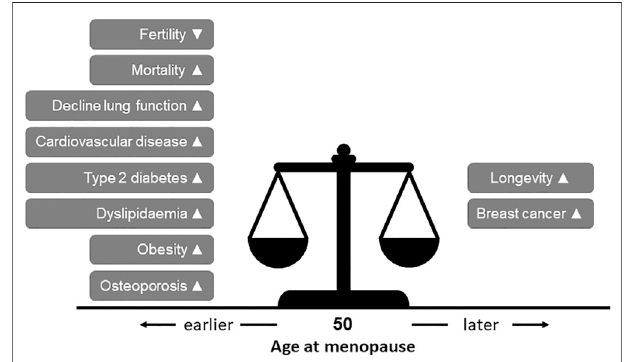
FIGURE 1 | The impact of age at menopause on women ’ s health. Data of numerous conventional epidemiological studies indicate that the timing of age of menopause increases ( ▲ ) or decreases ( ▼ ) the risk for various